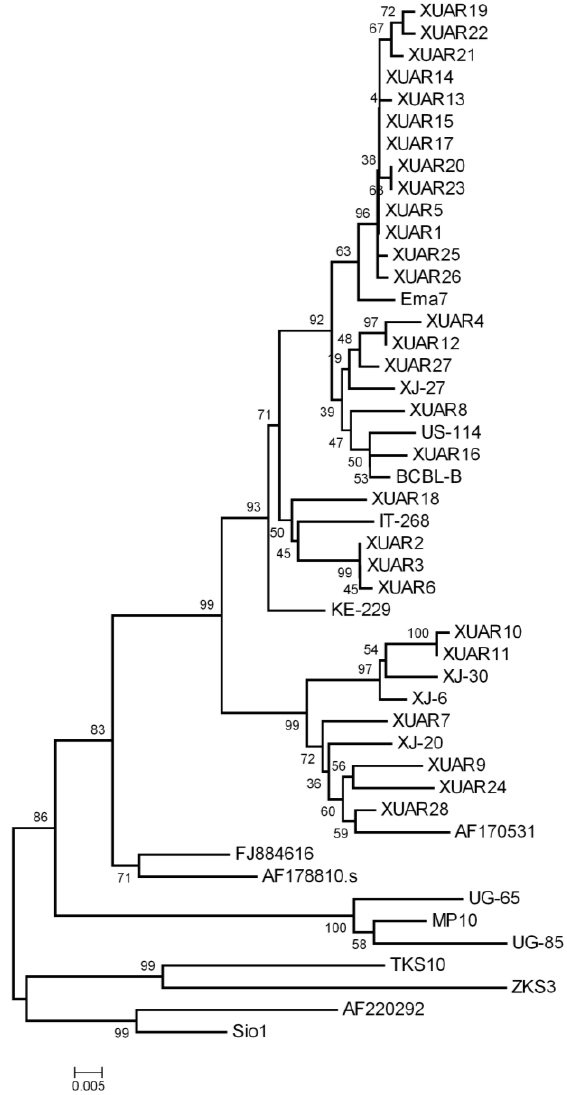
Figure 1. Phylogenetic tree of KSHV ORF-K1 DNA sequences constructed by MEGA (version 4.0.2) using the neighbor-joining algorithm. Relationships of KSHV isolates